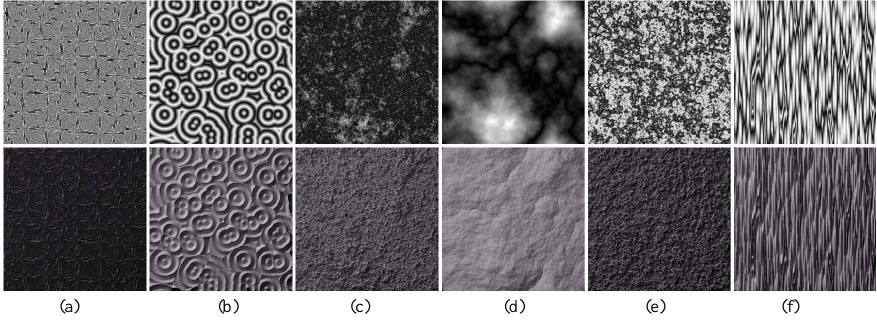
Figure 13. Textures generated by folding operations. First, row: height maps. Second row: relighting results. The source images of column ( a , b ) are cellular textures; the source images of column ( c , d ) are fractal textures; the source image of column ( e ) is a Perlin noise texture; and the source image of column ( f ) is a texton